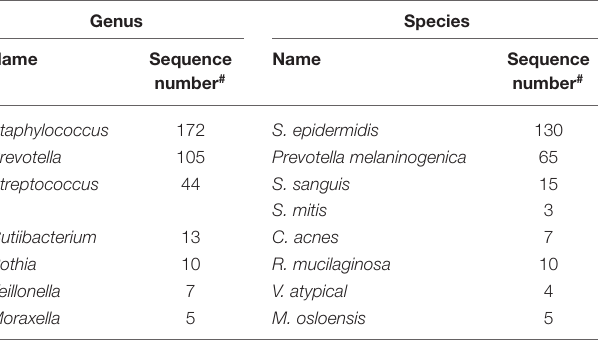
TABLE 1 | The other microorganisms detected by next-generation sequencing (NGS) in the BALF of the case. Genus